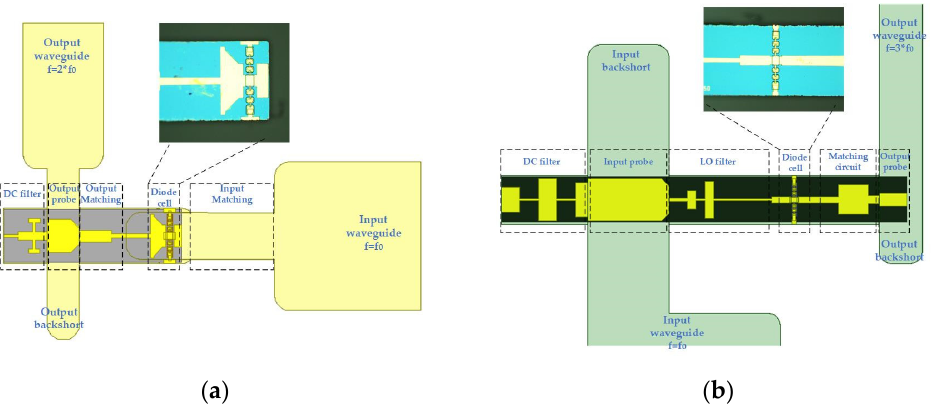
Figure 3. The overall circuit model in the high frequency structure simulator. ( a ) The structure of wideband doubler; ( b ) The structure of unbalanced tripler. The images of the diode cell in monolithic integrated circuit are added through a microscope.